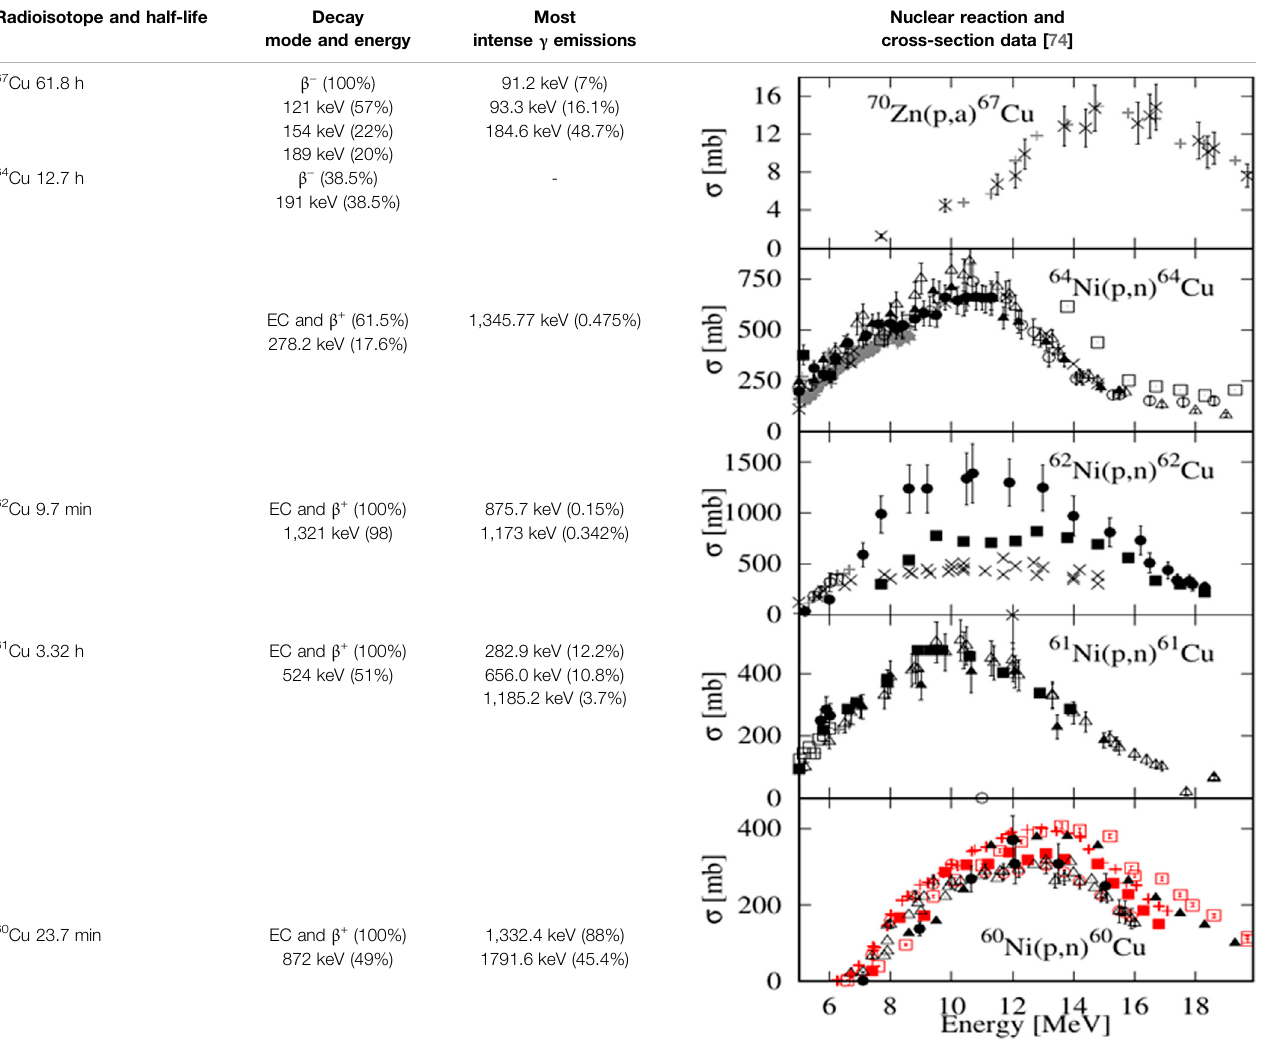
Most mode and energy intense γ emissions